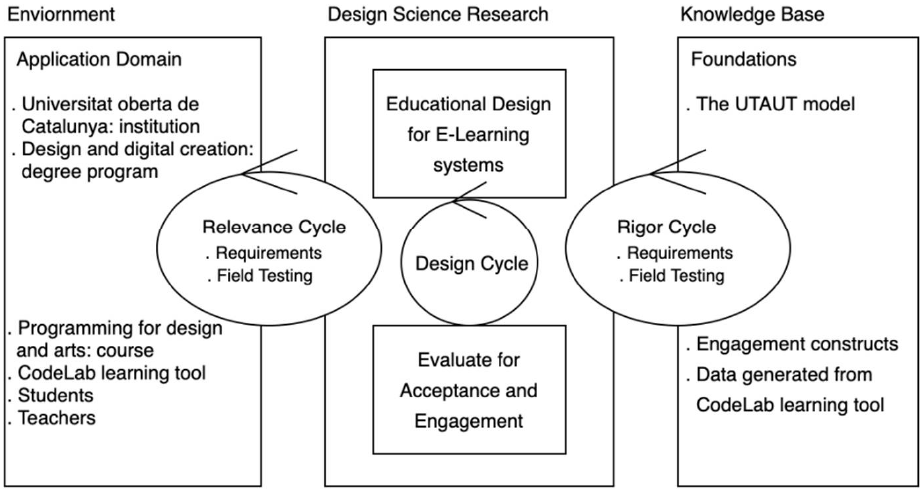
Figure 1. Design and creation adapted for CodeLab.